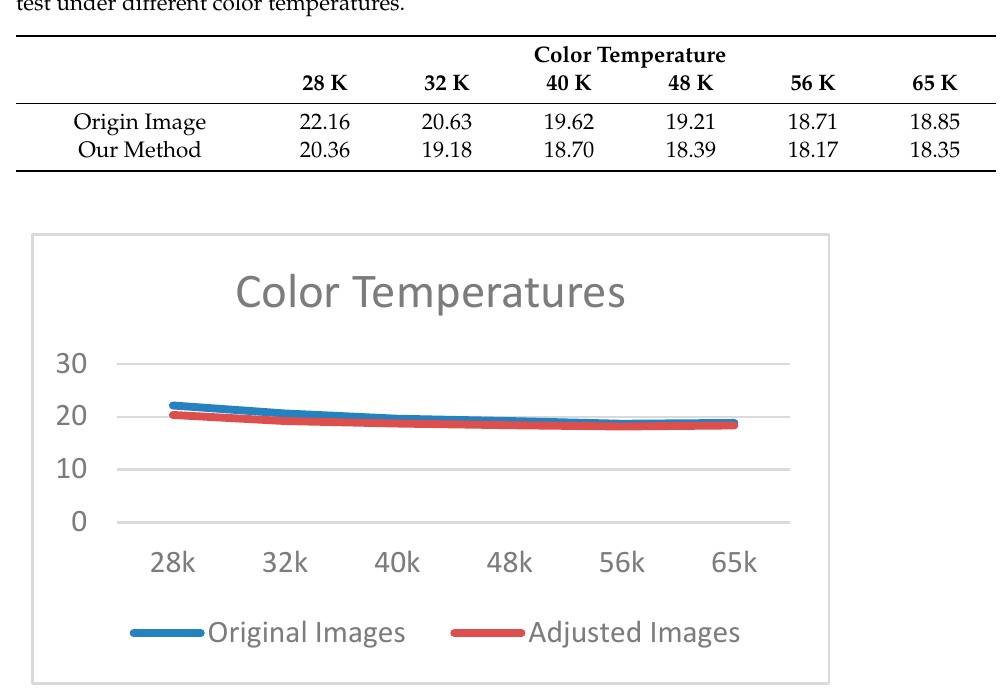
Figure 8. Curves at different color temperatures.